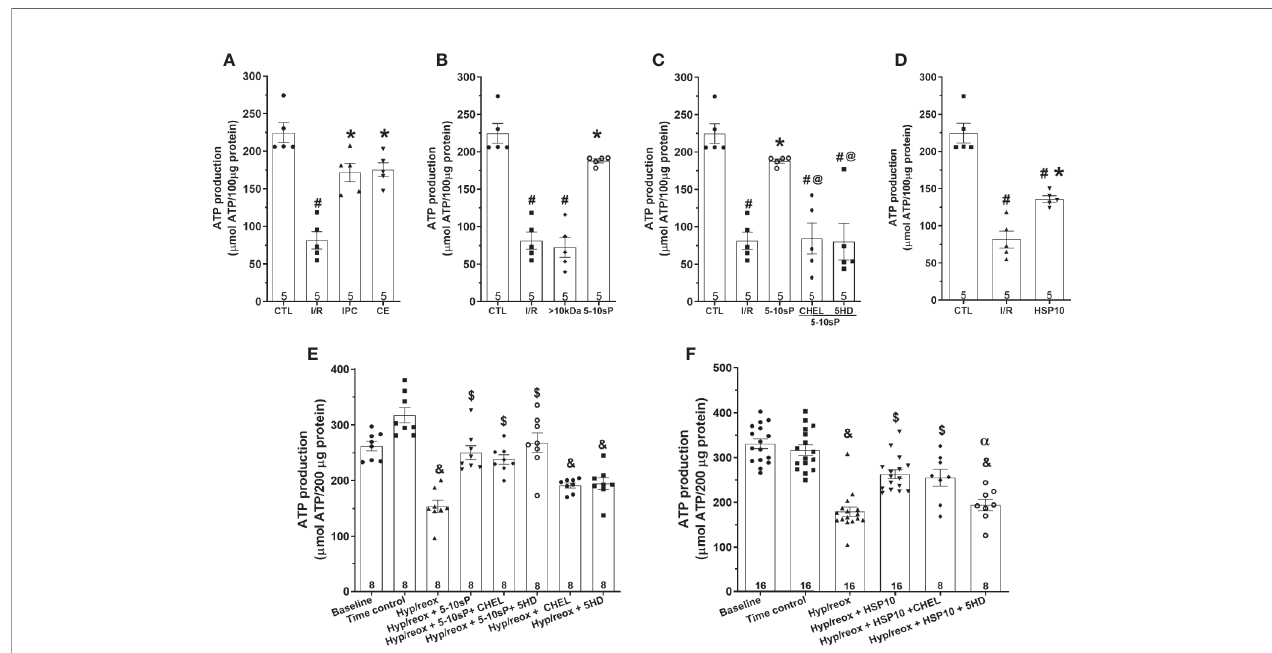
FIGURE 5 | Adenosine triphosphate (ATP) production of isolated mitochondria from rat hearts. (A – D) Isolated mitochondria from hearts submitted to I/R. Control (CTL), ischemia/reperfusion (I/R), ischemic preconditioning (IPC), preconditioned coronary ef fl uent transfer (CE), coronary ef fl uent fraction 5 – 10 kDa (5 – 10-sP) transfer, coronary ef fl uent fraction >10 kDa (> 10 kDa) transfer, 5 – 10-sP plus PKC inhibitor chelerythrine or mitochondrial K ATP channel blocker 5HD. (E , F) Isolated mitochondria from hearts submitted to I/R under 10 kDa-mitochondrial heat shock protein (HSP10) perfusion. Mitochondria respiration submitted to hypoxia/ reoxygenation and (F) HSP10 or (E) 5 – 10-sP with or without chelerythrine or 5HD incubation. Number in each column is n of hearts. # P < 0.05 vs . CTL, *P < 0.05 vs . I/R, @ P < 0.05 vs . 5 – 10 kDa, & P < 0.05 vs . Time control, $ P < 0.05 vs . hypoxia/reoxygenation, a P < 0.05 vs . hypoxia/reoxygenation +